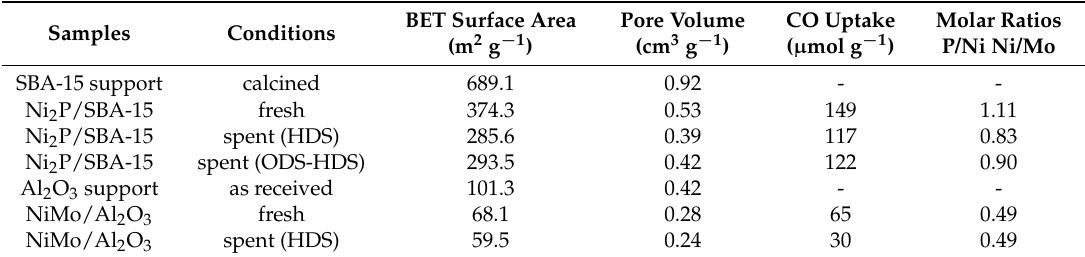
Table 1. Physical properties of Ni 2 P and NiMoS